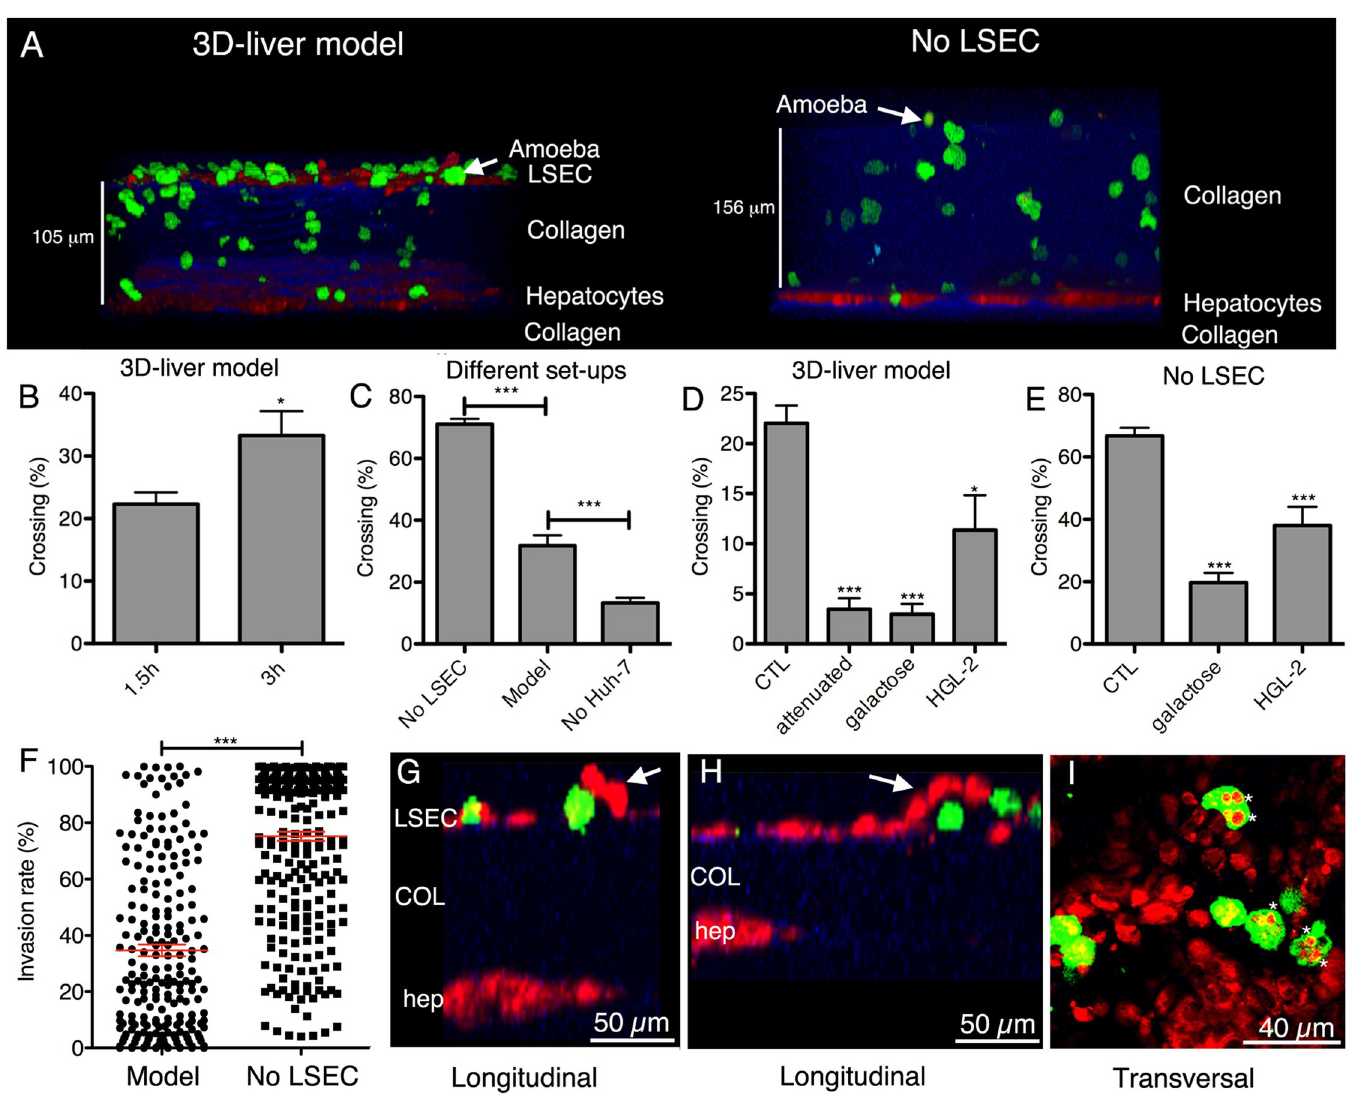
Fig 3. Illustration showing variations of a 3D liver infection model of E . histolytica infection in vitro. Hepatic cells (red), amoebae (green), and COL-I (collagen-I, blue) are shown. (A) Virulent trophozoites added to the medium adhere to the LSEC in the 3D liver model but not in the setup without LSECs (No LSEC) seen in transversal view of reconstructed 3D images. (B) Incubation of liver model with trophozoites for 1.5 and 3 hours. (C) Incubation of the distinct setups with trophozoites for 3 hours. (B–E) Percentage of amoeba crossing the LSEC layer or COL-I matrix. Infection of the liver model (D) with various E . histolytica strains in the presence of glucose/galactose for 1.5 hours and similarly, infection of the setup without LSEC (F) for 3 hours. (F) Parasite invasion rate at 3 hours for the model and the no LSEC setup showing 0% invasion at the LSEC and 100% at the hepatocyte layer z-position, respectively. Red bars indicate mean values. (G–I) Parasite interaction with the LSEC layer of the 3D liver model at 3 hours. In panels (G) and (H), the arrows point to LSEC detaching in the presence of trophozoites. In panel (I), the asterisks point out vesicular structures localized inside the trophozoites labeled with hepatic cell staining. Open-access image reused from [77]. LSEC, liver sinusoidal endothelial